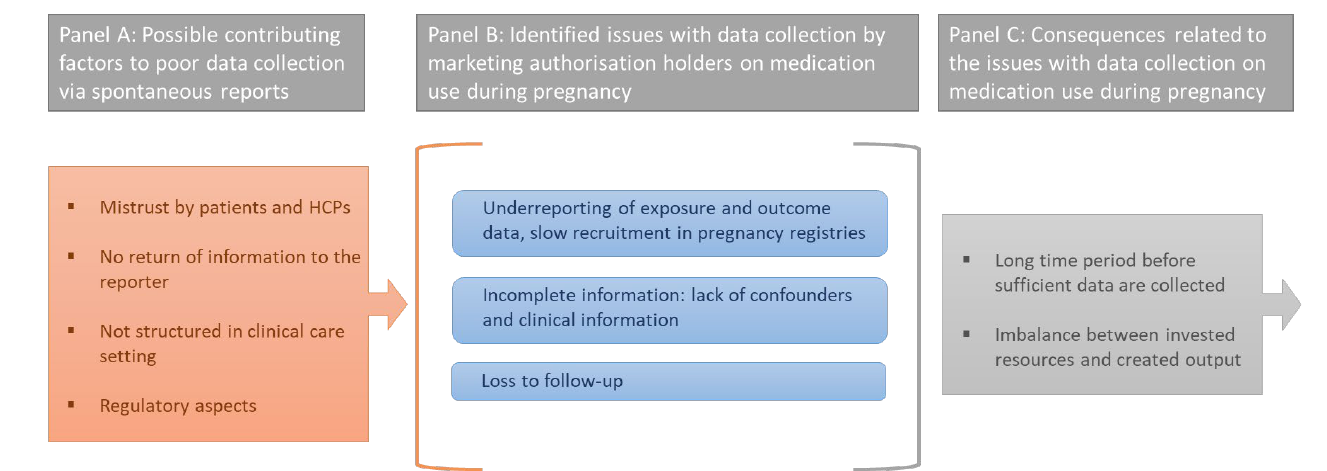
Figure 1. Overview of the identified issues (centre), possible contributing factors (left panel), and consequences related to data collection on medication use during pregnancy (right panel).